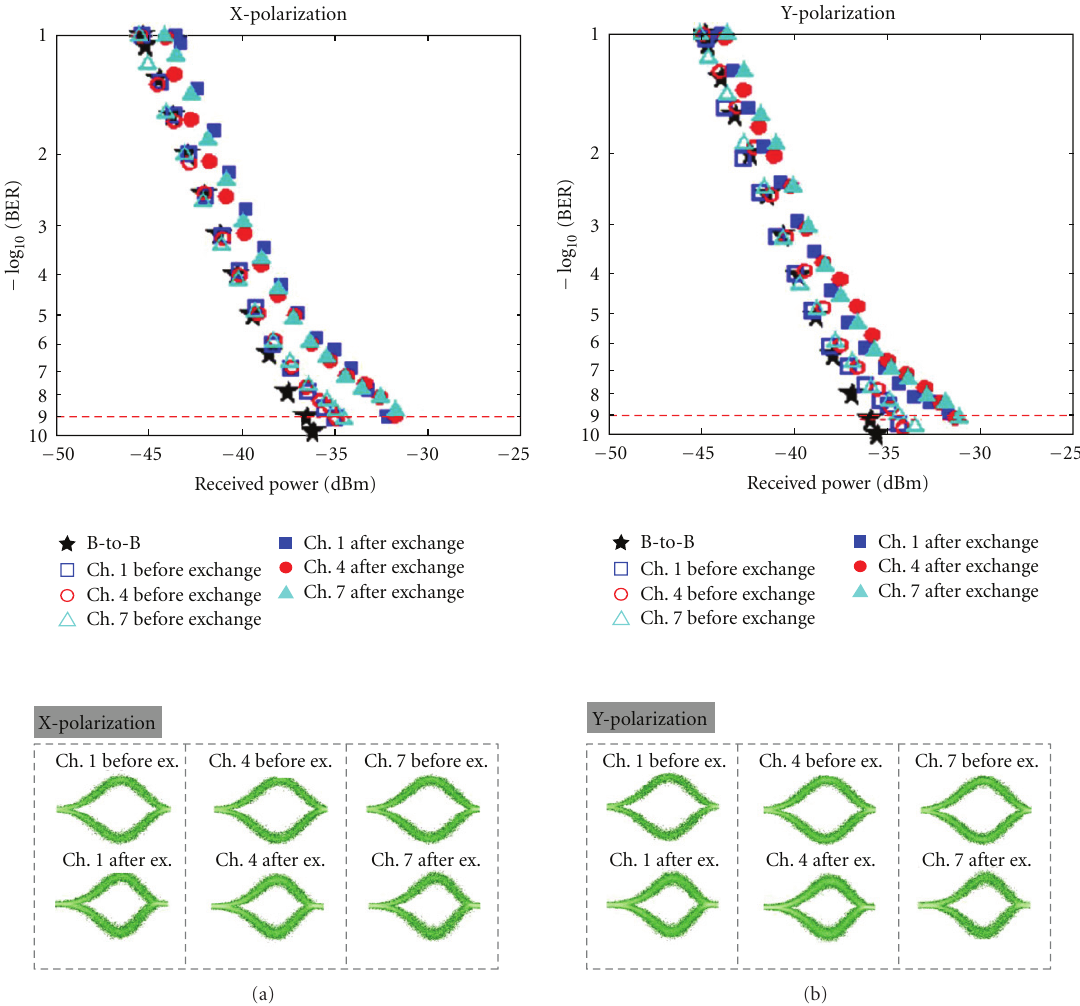
Figure 33: BER and balanced eyes of orthogonal tributary channel exchange of a 160 Gbit/s pol-muxed DPSK OTDM signal.